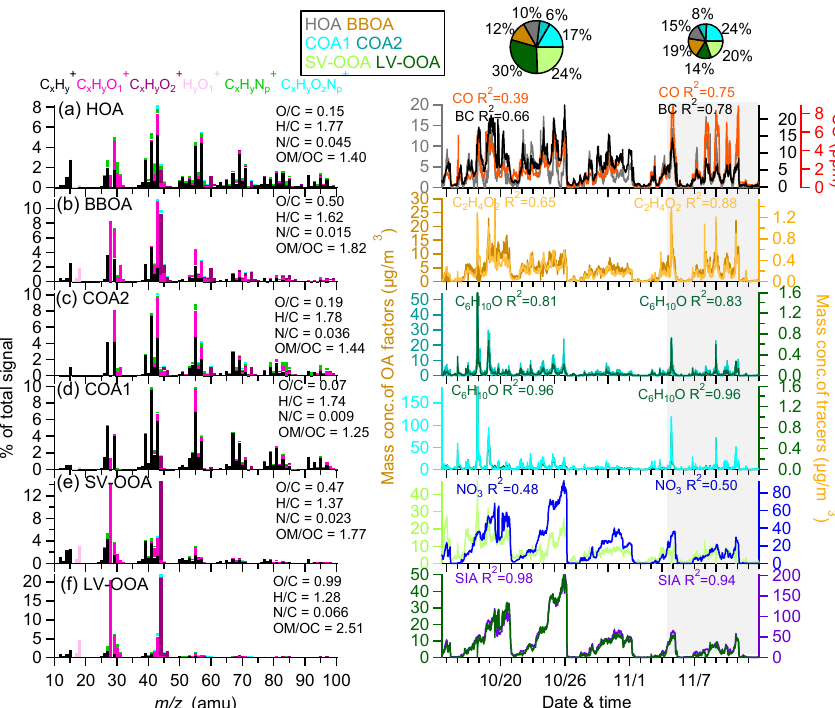
Figure 3. High-resolution mass spectra (HRMS; left panel) and time series (right panel) of six organic aerosol (OA) components: (a) hydrocarbon-like aerosol (HOA), (b) biomass-burning OA (BBOA), (c) cooking organic aerosol 2 (COA2), (d) COA1, (e) semi-volatile oxygenated OA (SV-OOA), and (f) low-volatility oxygenated OA (LV-OOA). Also shown in the right panel are the time series of tracers including C 6 H 10 O + , C 2 H 4 O + , CO, black carbon (BC), nitrate, and SIA (sulfate + nitrate + ammonium). The two pie charts show the av- 2 erage chemical composition of PM 1 measured before and during the Asia-Pacific Economic Cooperation (APEC) summit, respectively. The correlation coefficients between OA factors and external tracers measured before and during APEC are also shown in the